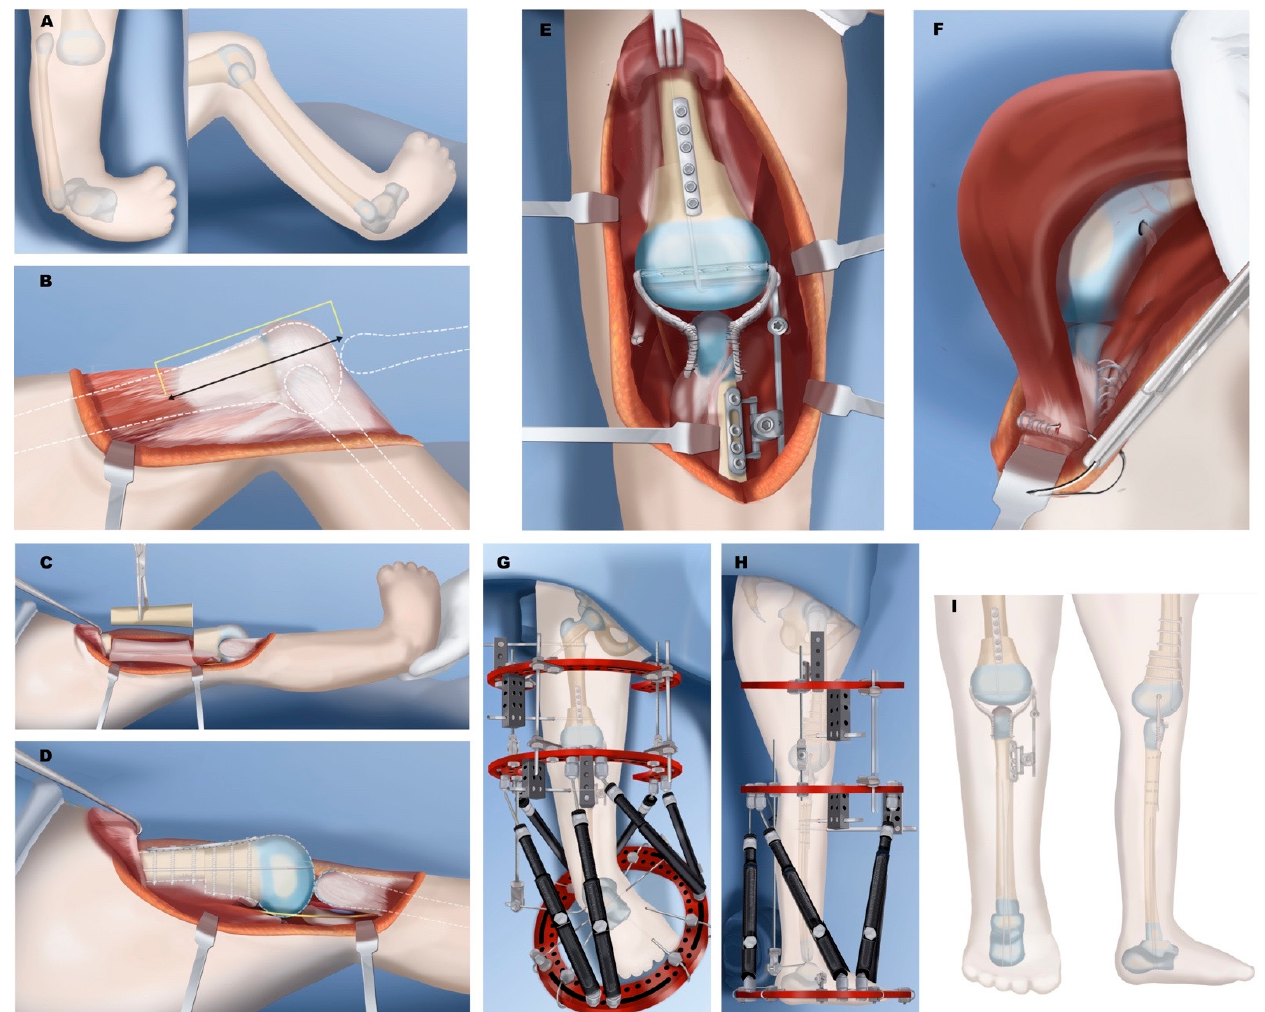
Figure 11. Treatment of Paley type 5C. ( A ) Complete aplasia of tibia with no patella. ( B ) Quadriceps are distally absent and end in distal femur. Femur needs to be shortened significantly to be able to bring the quadriceps to the level of the knee joint. ( C ) Femoral shortening osteotomy. ( D ) Plate fixation and intramedullary pinning of femoral osteotomy and distalization and centralization of fibula. ( E ) Knee stabilized with IJS internal articulated joint distractor. Collateral ligaments made from autograft or allograft. Reconstruction of collateral ligaments and placement of internal joint distraction system. ( F ) After quadricepsplasty, quadriceps muscle is advanced and sutured to the fibula head. ( G ) Placement of two-level external fixator: upper two rings with hinges for articulated stabilization of knee; lower two rings for gradual foot distraction. ( H ) Once talus is beneath the fibula and foot at 90 ° , physeal sparing fusion of foot to talus is carried out. ( I ) Final results after fixator removal. The IJS device side arm is disconnected 6 months later to allow for proximal fibular growth.